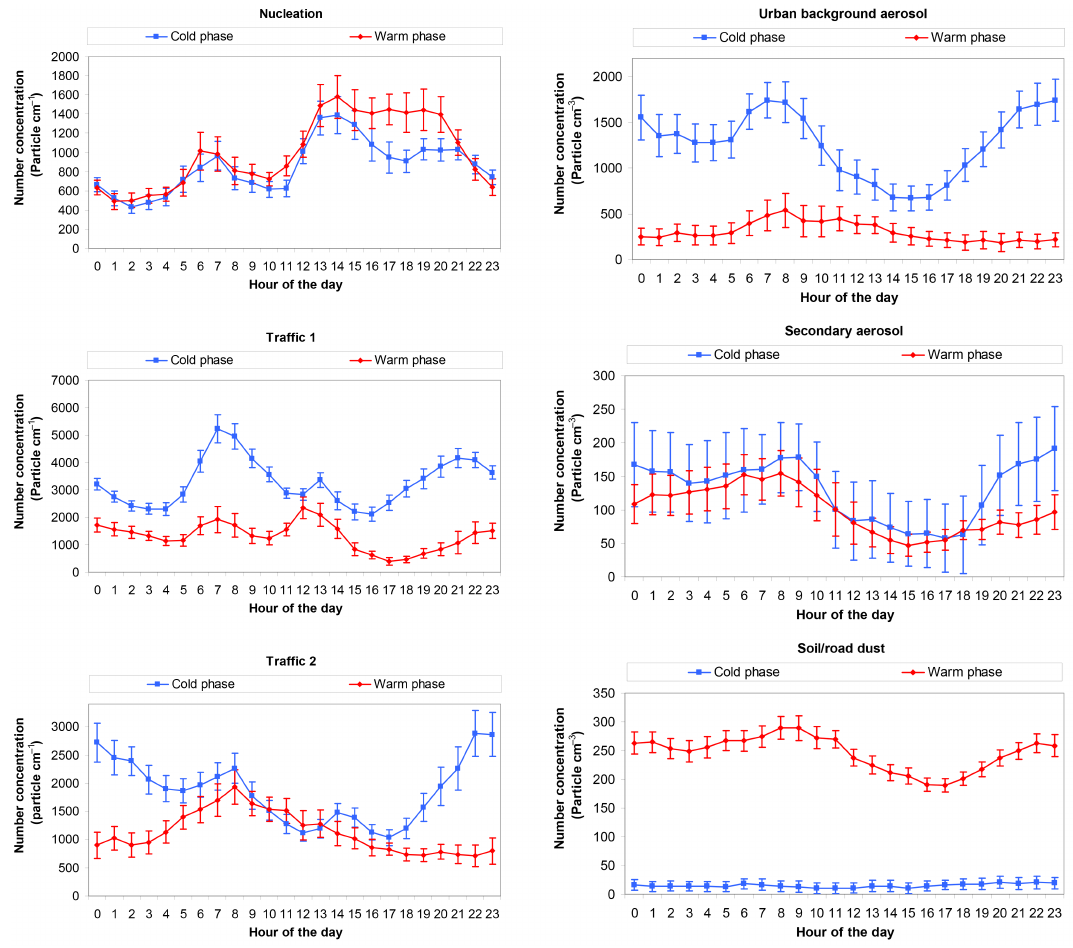
Figure 7. Diurnal variations (geometric means) of number concentrations (particlescm − 3 ) from each factor resolved by the PMF model in the cold and warm phases. Error bars correspond to 1 standard